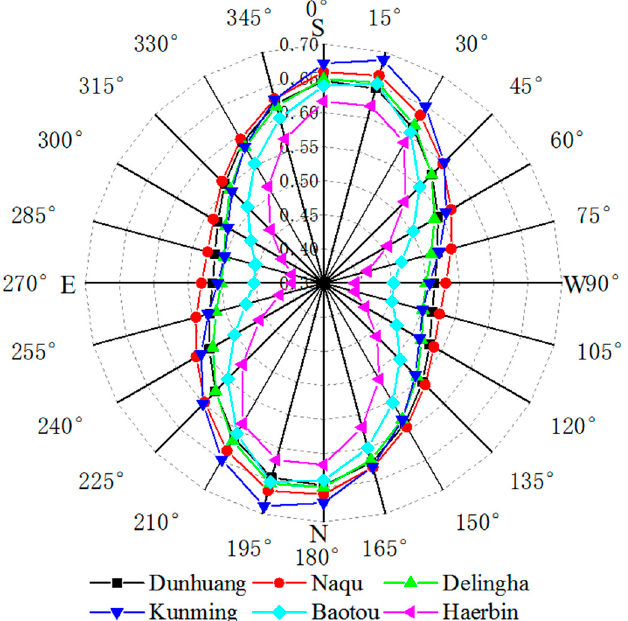
Figure 9. Variation of the effective tracking factor σ of an SDC system in different areas under an azimuth axis tilt error.